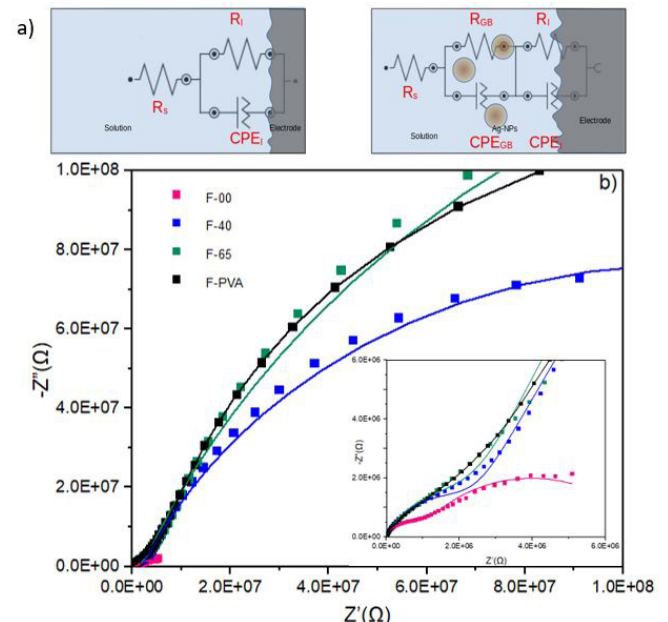
Figure 5. a): Schematic representation of the electrochemical cell and the proposed electric equivalent circuits for pristine PVA films (left), and AgNP loaded PVA films (right). b): Nyquist plot for pristine PVA films and films loaded with different AgNPs showing in the inset the magnification of the high-frequency region. Symbols: experimental data. Continuous lines: fits using the suggested equivalent